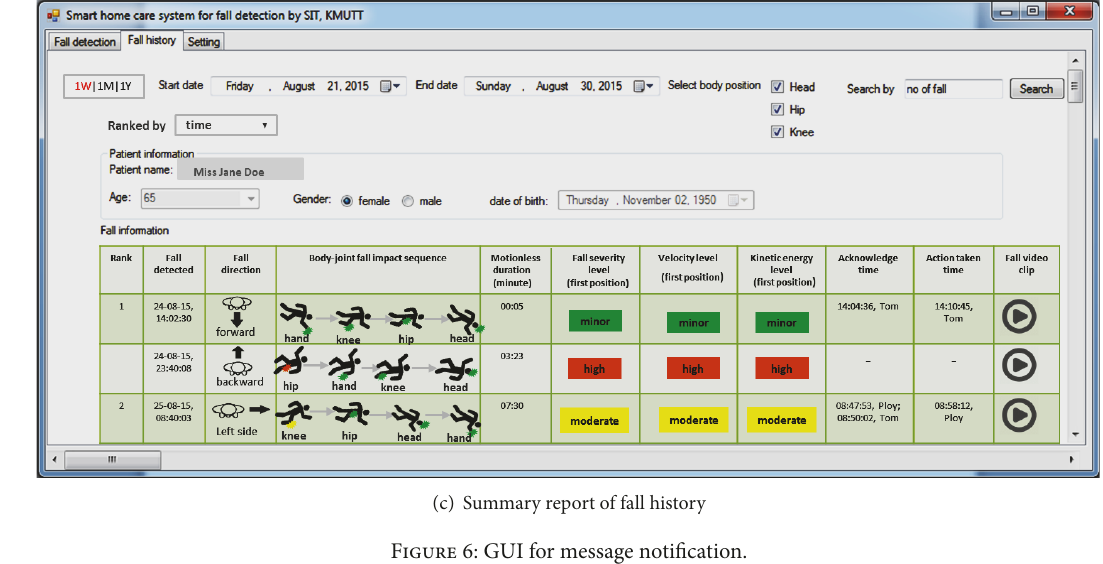
Figure 6: GUI for message notification.